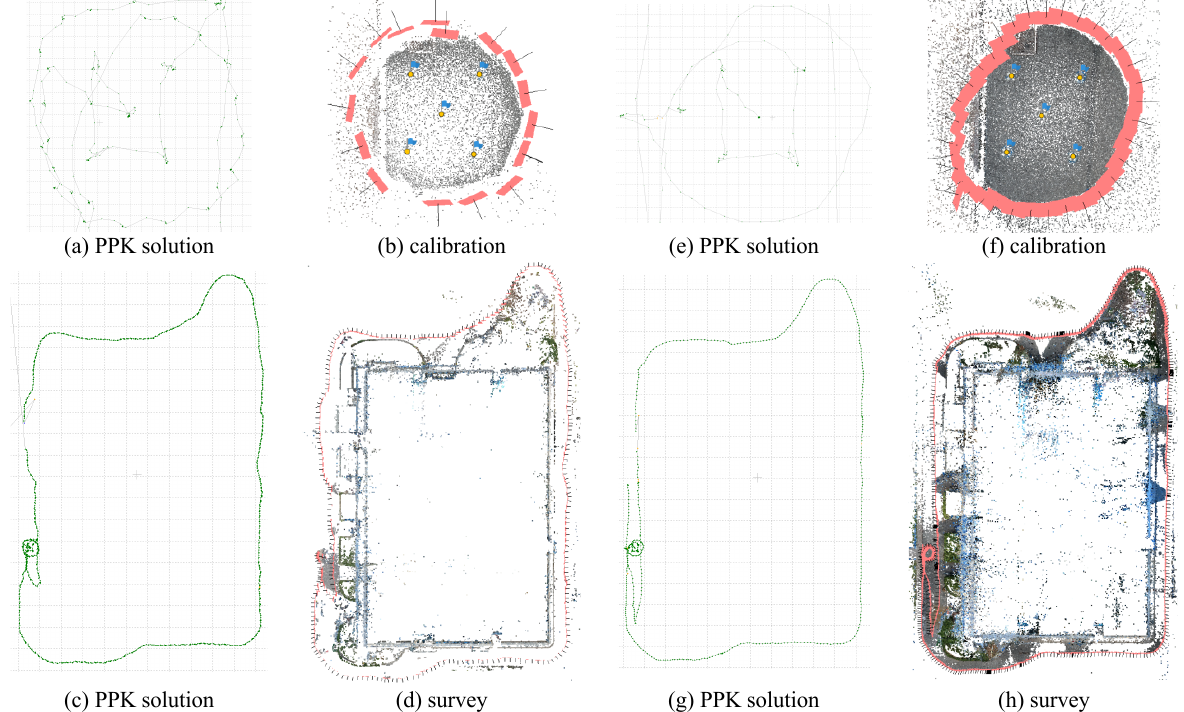
Figure 7: Calibration procedure (top row) and survey results (bottom row). Results for the rapid-static approach with all GNSS camera position (a-d) and same information for the kinematic approach with frames from video (e-h). In (b, d, f, h) the Metashape sparse clouds and camera positions are shown with red frames, the PPK solutions processed with RTKLIB are shown in (a, e, c,